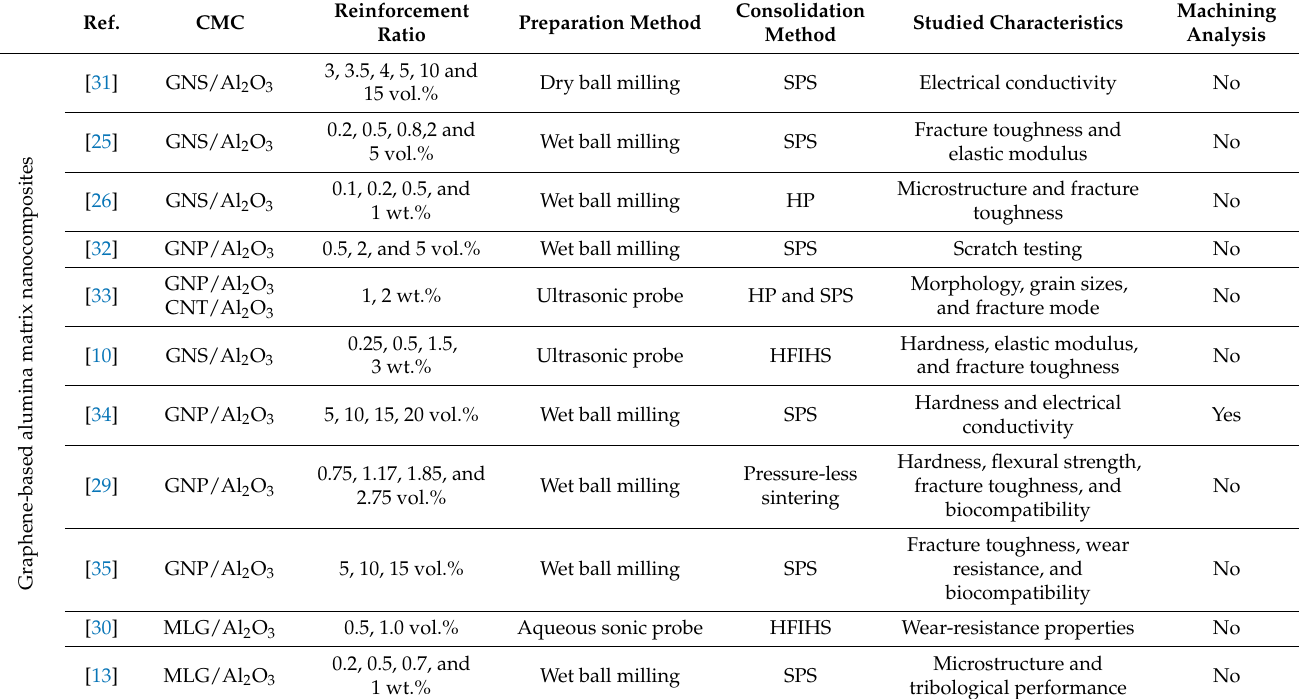
Table 1. The fabrication techniques of graphene-reinforced alumina ceramic nanocomposites pre- sented in the